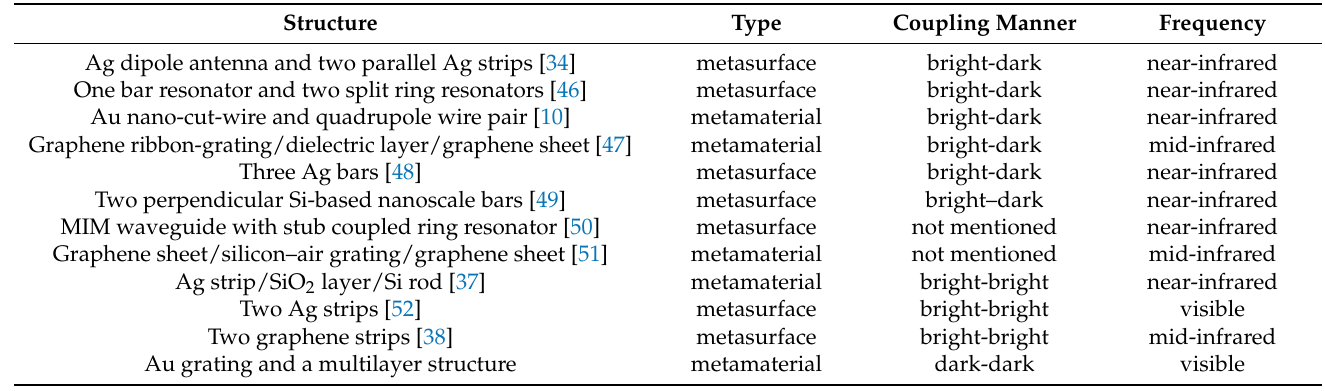
Table 1. The summary of EIT-like effect in different